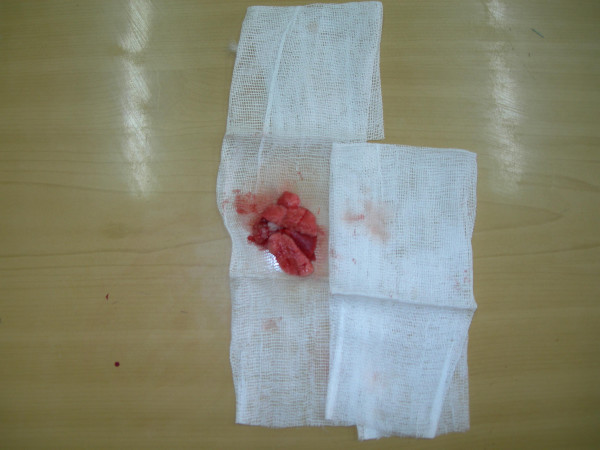
At the end of the experiment, right lung tissue of rats was removed. It was seen extend and lobulate position.